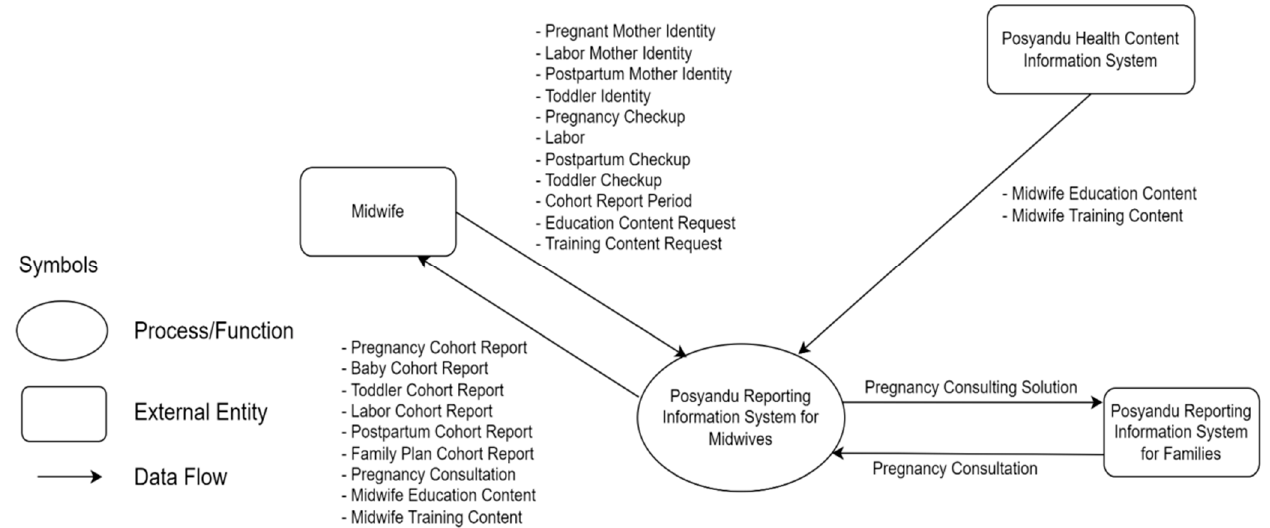
Figure 3. Data Flow Diagram (DFD) level 0 in mHealth application for a midwife.